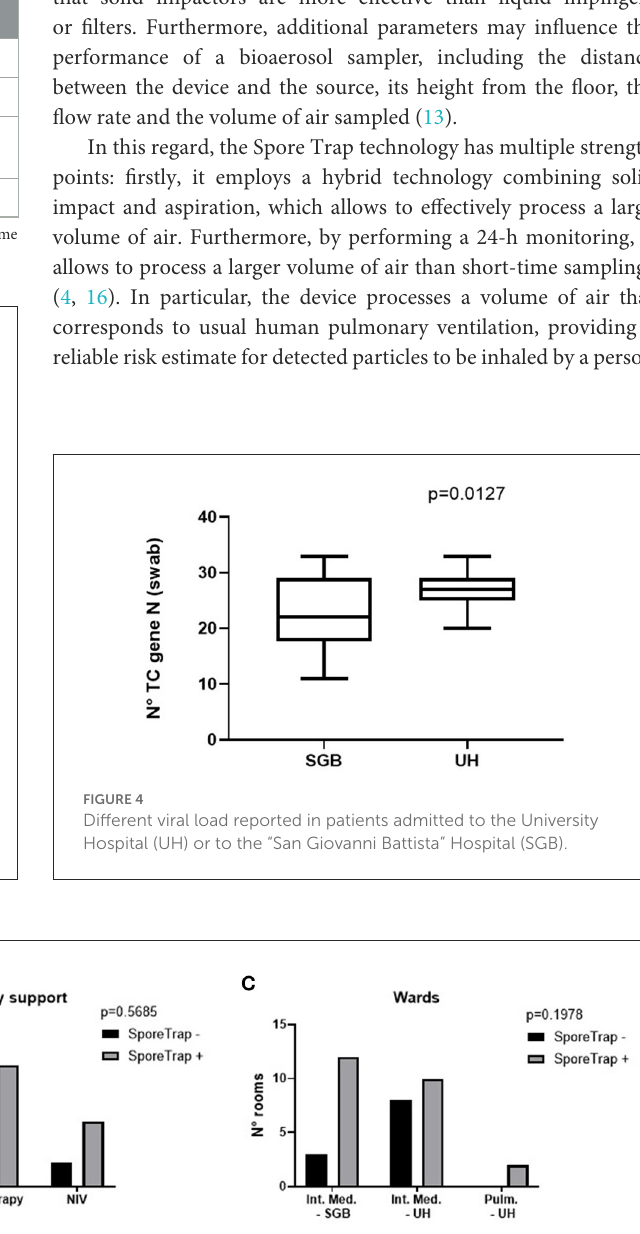
FIGURE3 Possible factors influencing the detection of Severe Acute Respiratory Syndrome Coronavirus 2 (SARS-CoV-2) by the SporeTrap technology. (A) Double rooms vs. single rooms. (B) Presence and modality of respiratory support. (C) Site of detection. NIV, non-invasive ventilation; SGB,